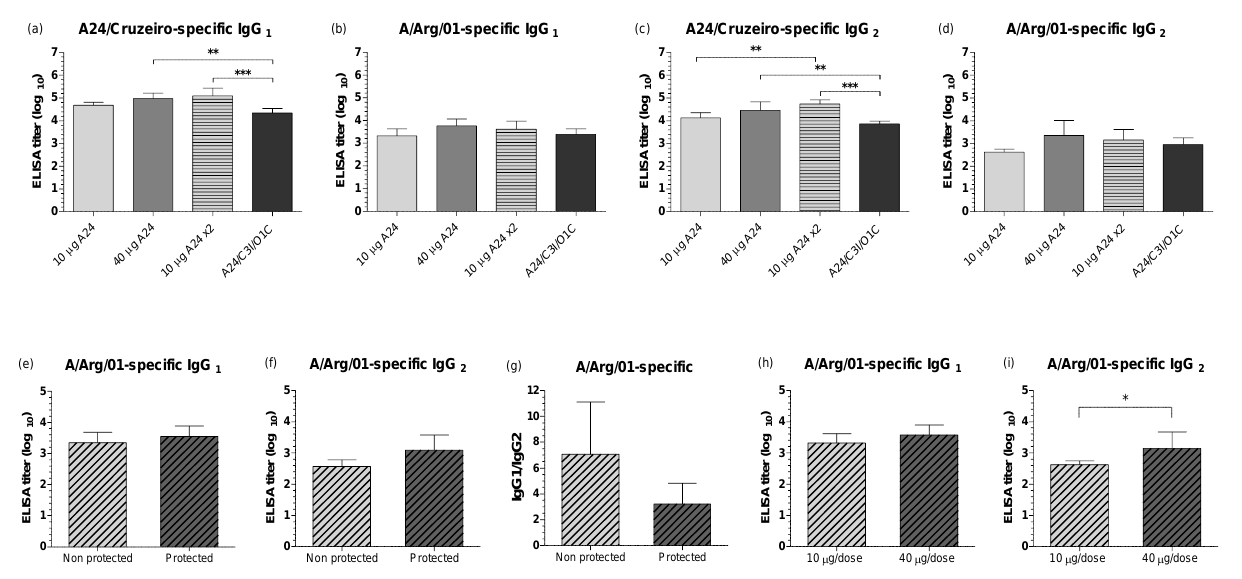
Figure 5. FMDV-specific IgG isotype responses in vaccinated animals at 30 dpv. ( a – d ) FMDV-specific IgG1 and IgG2 measured by ELISA for each experimental group against A24/Cruzeiro ( a , c ) and A/Arg/01 ( b , d ) strains. Results are expressed as the log 10 of the mean titer for each vaccine group at 30 dpv. ( e , f ) IgG isotype responses in animals protected and non-protected to the heterologous challenge. Results are expressed as the log 10 of the mean titers for IgG1 ( e ) or IgG2 ( f ) against the A/Arg/01 strain. ( g ) Ratio between mean IgG1 and IgG2 titers obtained by ELISA for protected and non-protected steers against the A/Arg/01 strain. ( h , i ) IgG isotype responses against FMDV A/Arg/01 strain according to the antigenic payload of the formulations. Animals were grouped as 10 µ g/dose (including the A24 10 µ g group) or 40 µ g/dose (including the A24/C3I/O1C and A24 40 µ g groups). FMDV-specific IgG1 ( h ), and IgG2 ( i ) antibodies against the A/Arg/01 strain at 30 dpv were measured by ELISA, expressed as the log 10 of the mean titers. For all panels, bars represent mean values of each group ± SD. Asterisks denote statistical differences between experimental groups * p ≤ 0.05 (Mann – Whitney test) and ** p ≤ 0.01 *** p ≤ 0.001 (ANOVA).